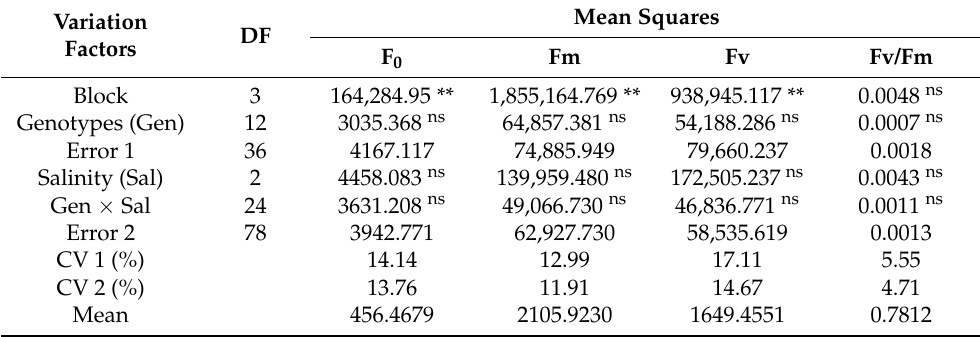
Table 6. Summary of analysis of variance of chlorophyll a fluorescence analysis on dark stage: initial fluorescence (F0), maximum fluorescence (Fm), variable fluorescence (Fv), and quantum efficiency of photosystem II (Fv/Fm), of combinations of ‘Tahiti’ acid lime ( Citrus × latifolia (Yu. Tanaka) Tanaka) with 13 rootstocks under water salinity, at 270 days after the onset of saline water irrigation. Mean Squares Variation DF Factors F 0 Fm Fv Fv/Fm Block